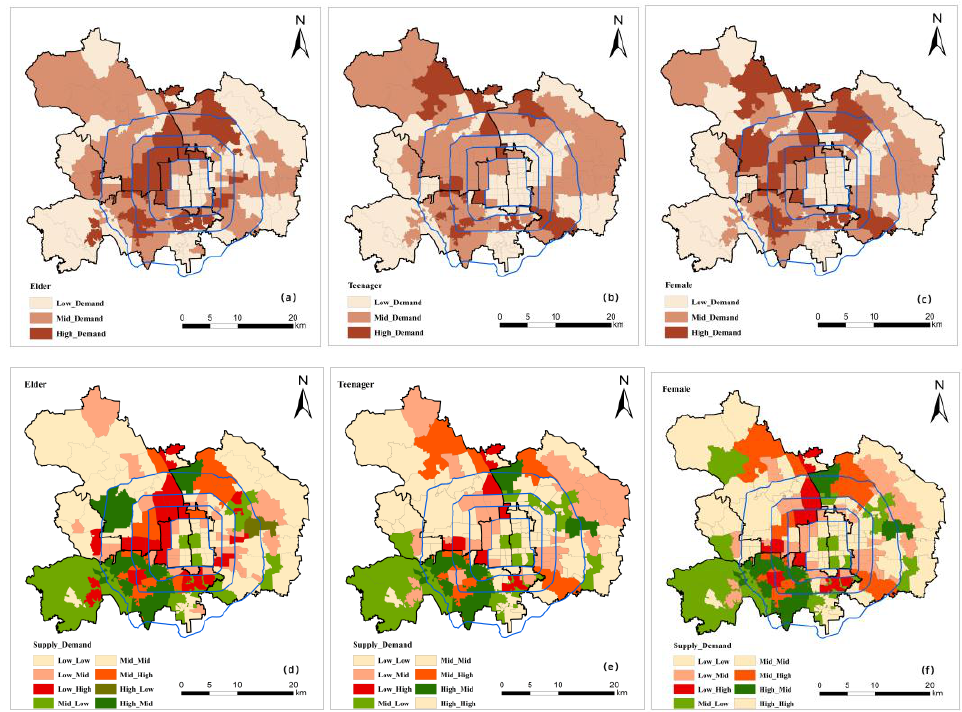
Figure 7. ( a ) Spatial distribution pattern of the number of elder in the sub-district; ( b ) Spatial distribution pattern of the number of teenagers in the sub-district; ( c ) Spatial distribution pattern of the number of females in the sub-district; ( d ) Matching the supply and demand of TPS with the elder; ( e ) Matching the supply and demand of TPS with the teenager; ( f ) Matching the supply and demand of TPS with the female.